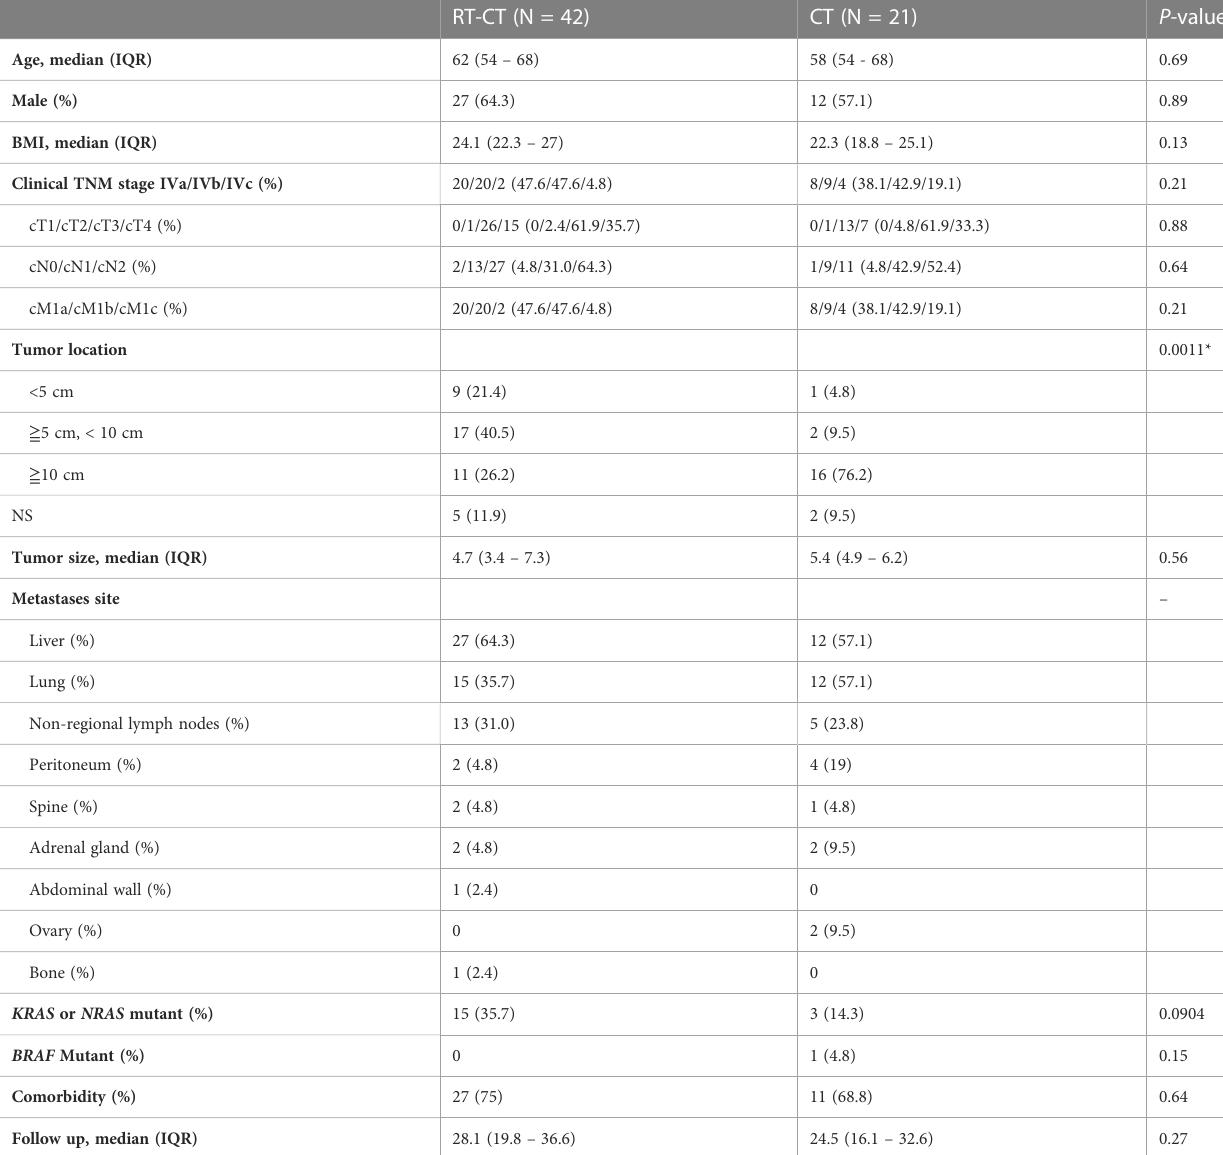
TABLE 1 Demographics of patients with stage IV locally advanced rectal cancer and the characteristics of their disease in the RT-CT 1 and CT 2